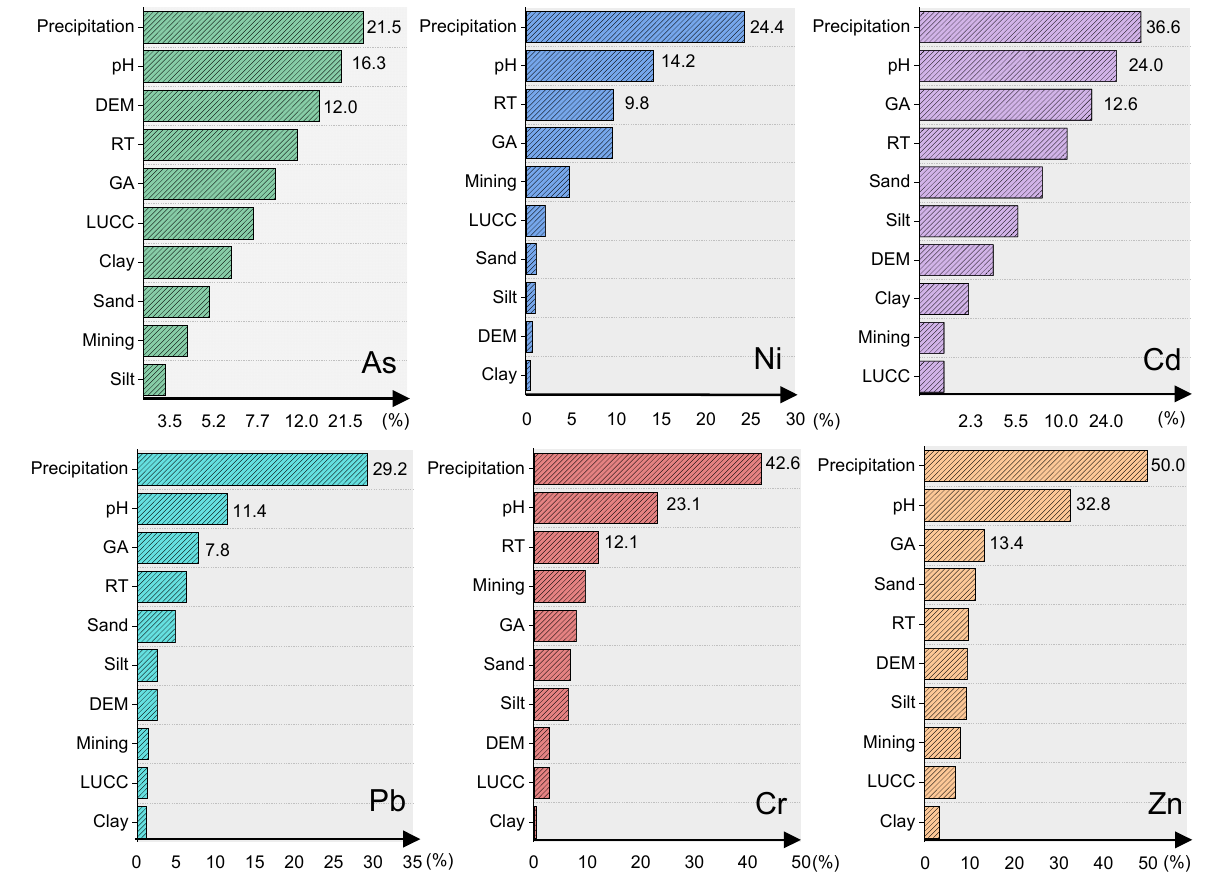
Figure 6. Source contribution of 10 factors to soil HM generated by Geo-detector models in the YTRB. Table 4. Effects of the interaction between each pair of driving factors on the enrichment of the As concentration in the YTRB.